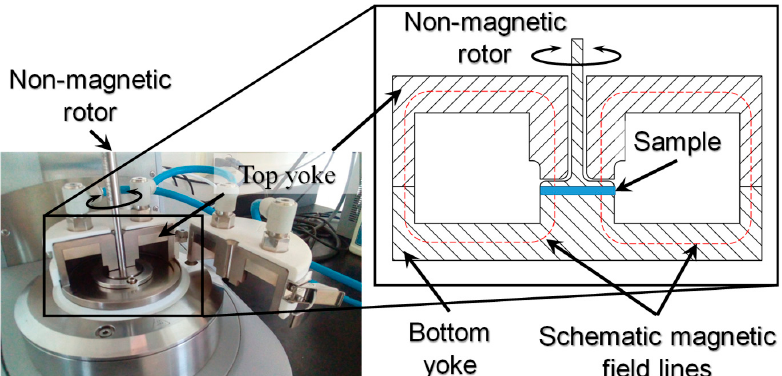
Figure 4. Tensile test set up and its schematic magnetic field applied on the magnetorheological elastomer (MRE) samples, according to the solenoid design and desire experimental measurements. The maximum magnetic field variation along the specimen is only 4% due to the solenoid length relative to the tensile sample material length. Additionally, the experimental set up allows the magnetic field lines to be parallel to the micro particle arrangement inside the material sample.